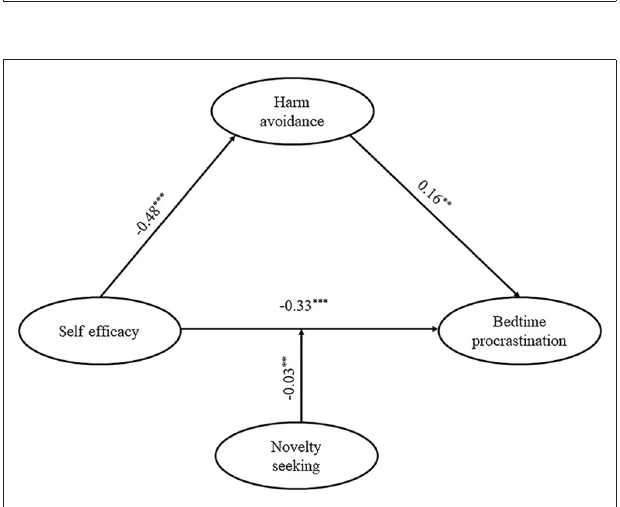
FIGURE 3 | Theoretical research model with standard